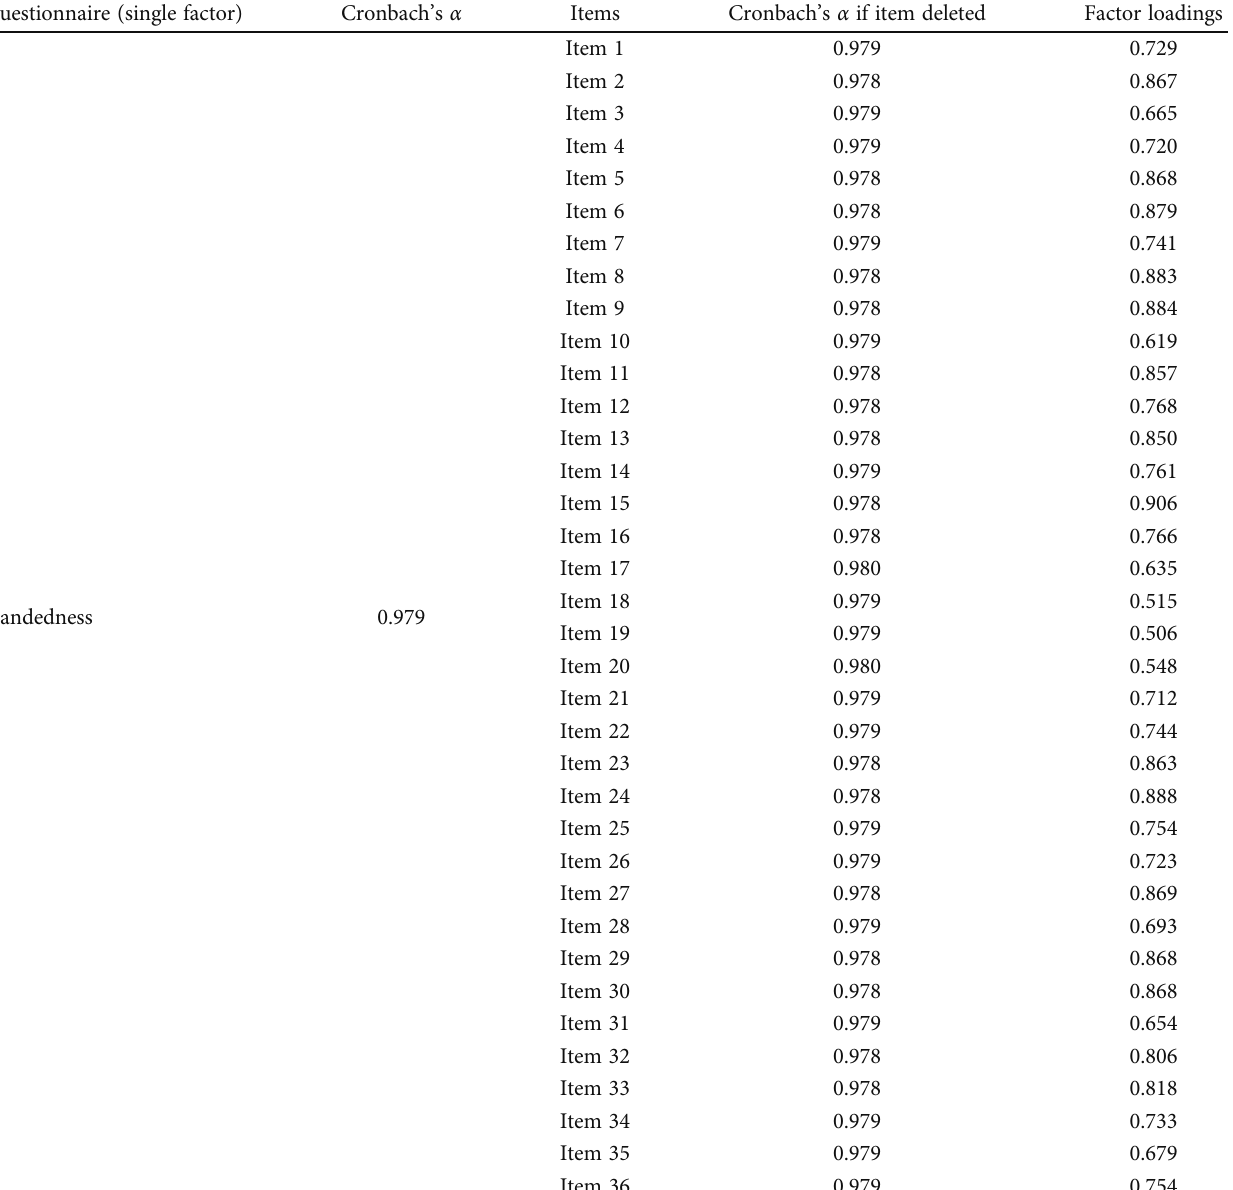
Table 3: Internal consistency, rotated factor loadings for the WHQ-Ar 36 items using principal axis method with the explained variance for the factor, n = 290